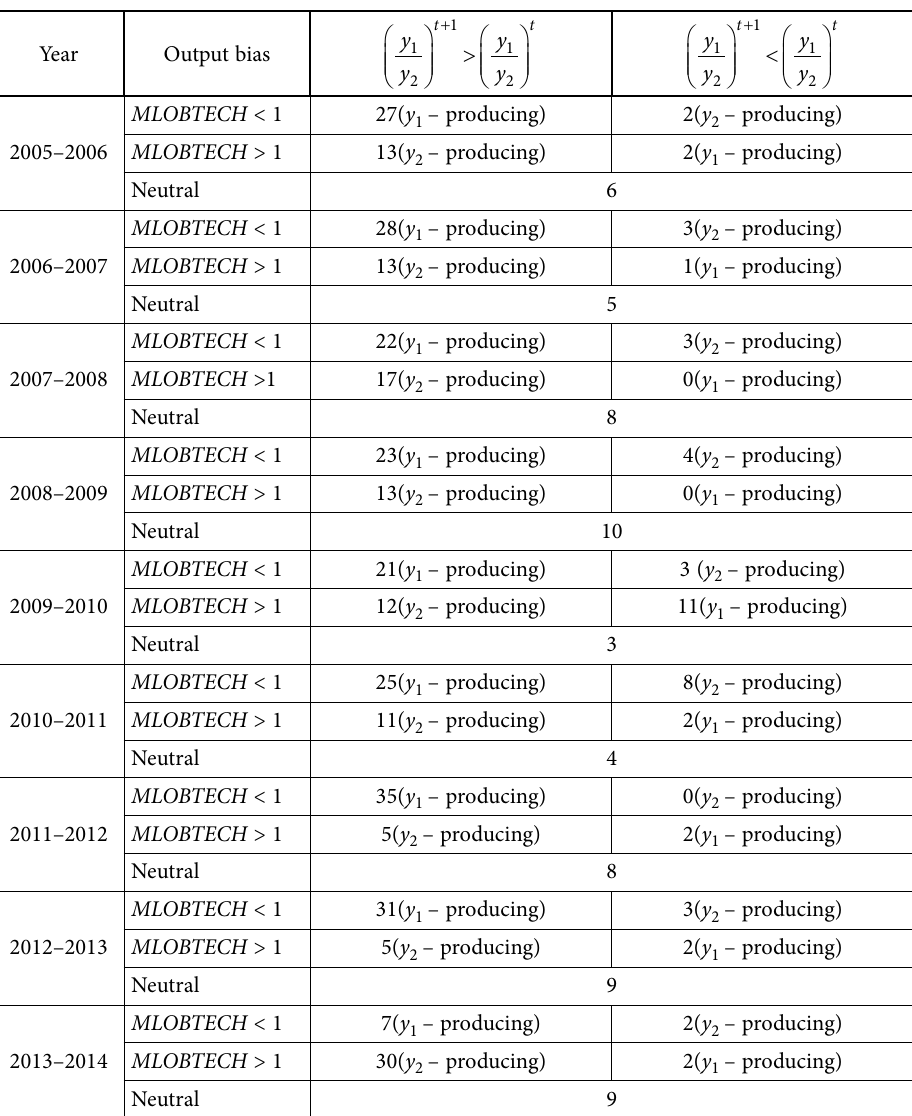
Table 7. Output biased technological changes of the three major urban agglomerations during